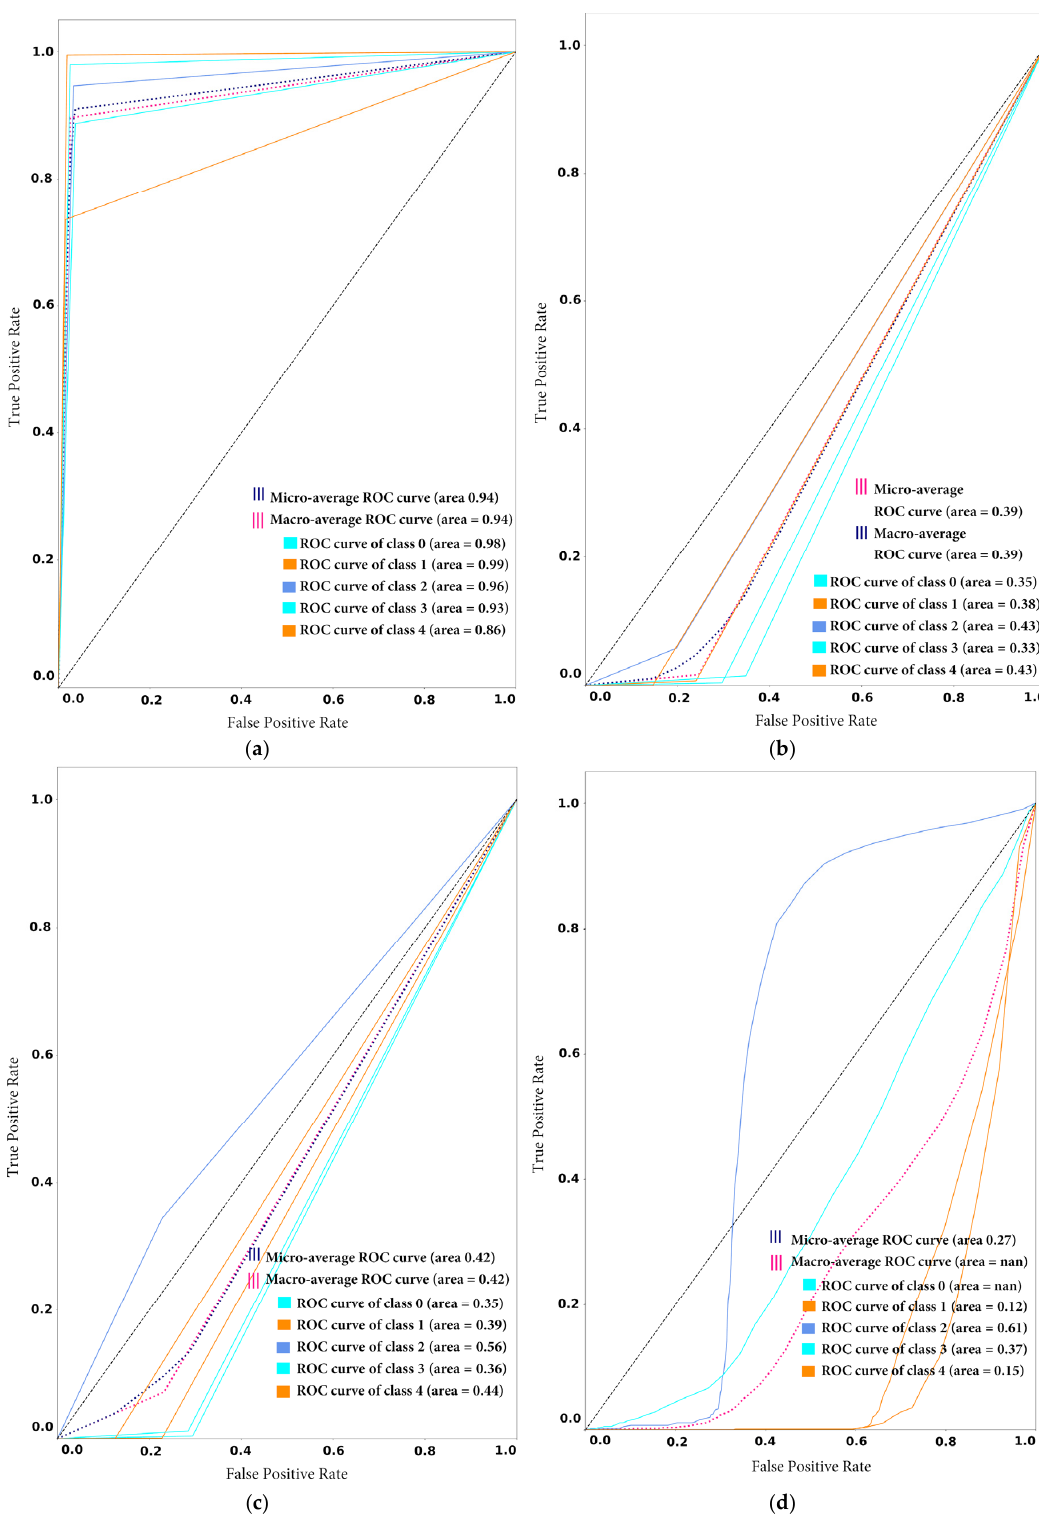
Figure 13. Receiver Operating Characteristic (ROC) curve after arrival new class: ( a ) ROC curve of proposed framework ( b ) ROC curve of Ensemble CNN ( c ) ROC curve of Ensemble SVM ( d ) ROC curve of Random